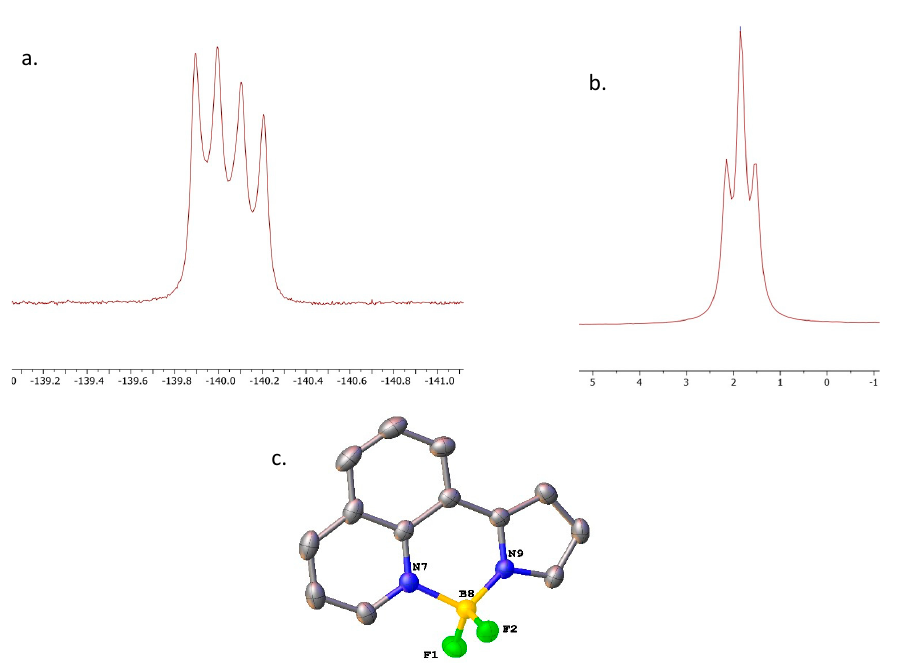
Figure 2. ( a ) 19 F NMR spectrum (282 MHz, CDCl 3 ) of the pyrrolylquinoline-BF 2 complex 8 . ( b ) 11 B NMR spectrum (96 MHz, CDCl 3 ) of the pyrrolylquinoline-BF 2 complex 8 . ( c ) X-ray single crystal analysis of pyrrolylquinoline-BF 2 complex 8 (hydrogen atoms have been omitted for clarity). The corresponding pyrrolylquinoline BPh 2 complex 9 was accessed according to the indole 3 [41]. The pyrrolylquinoline intermediate 13 was treated with two equivalents of triphenylborane 14 in toluene under reflux. The BPh 2 chelate 9 was isolated in 68% yield (Scheme